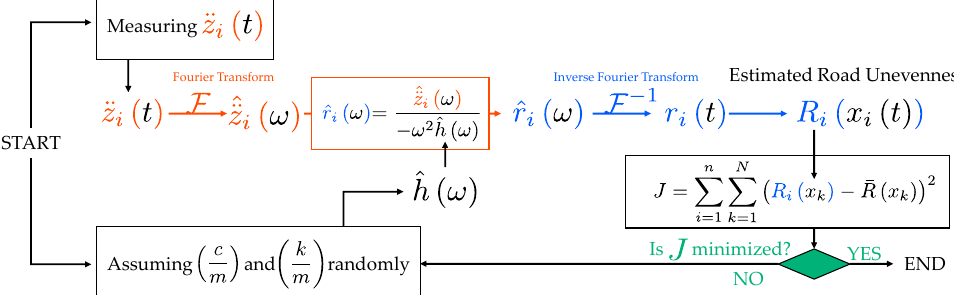
Figure 6. Flowchart of the traditional method of estimating road unevenness, R ( x ) , without prior information about the vehicle parameters